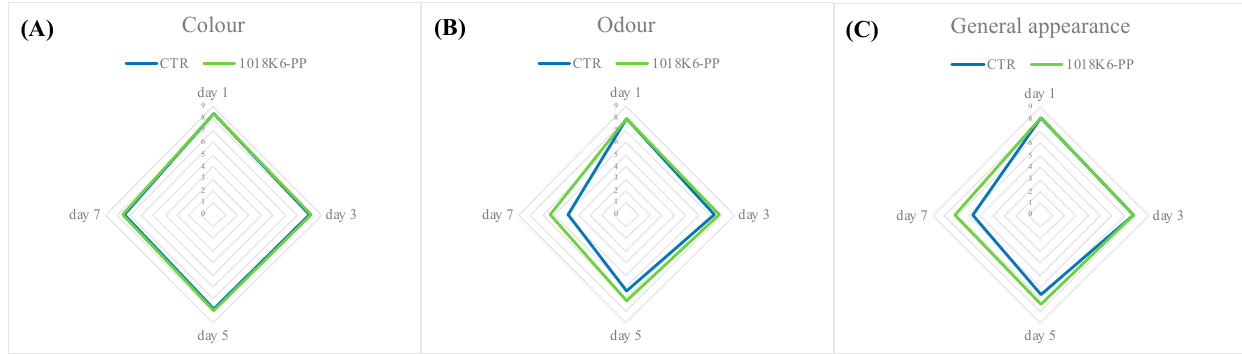
Figure 9. Changes in colour ( A ), odour ( B ), and overall appearance ( C ) of bonito fish burgers during storage period. CTR (blue lines)—PP films without 1018K6; 1018K6-PP (green lines)—PP films functionalized with 1018K6.